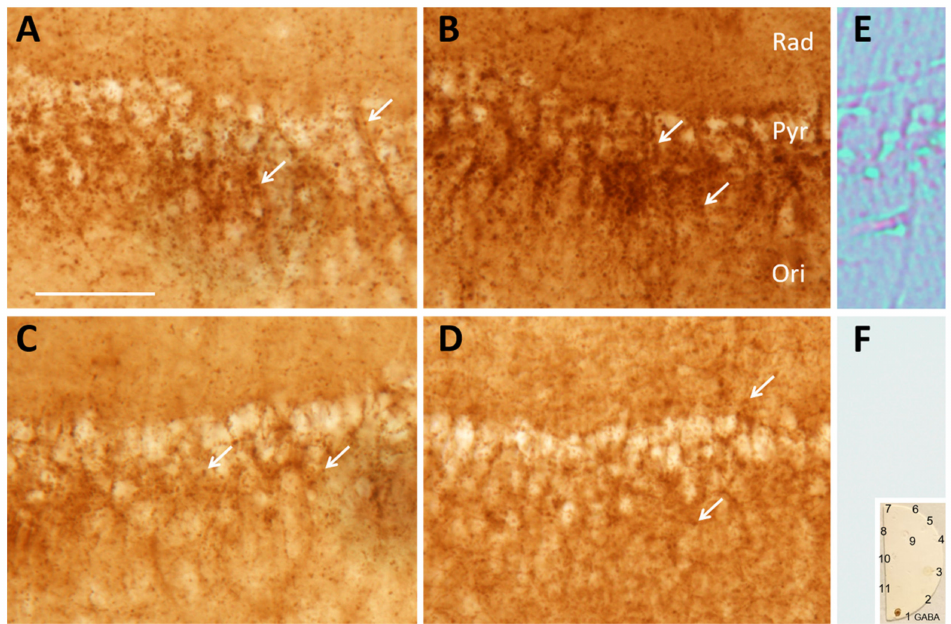
Figure 3. GABA synthesis in nerve endings is rescued by glutamine supplementation in Slc38a1 +/+